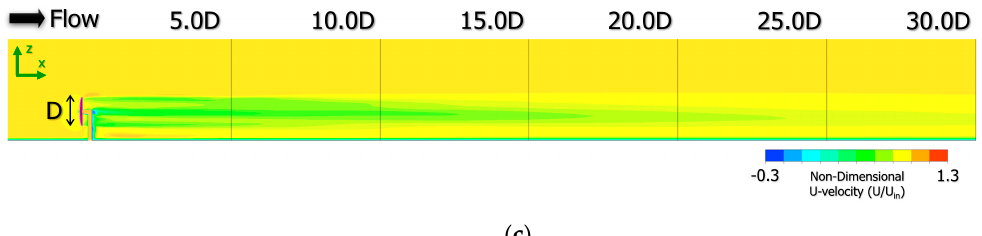
Figure 16. Spatial distribution of U-velocity for time-averaged flow field in the x–z plane (side view) at y = 0: ( a ) N = 4, ( b ) N = 10, and ( c ) uniform flow.